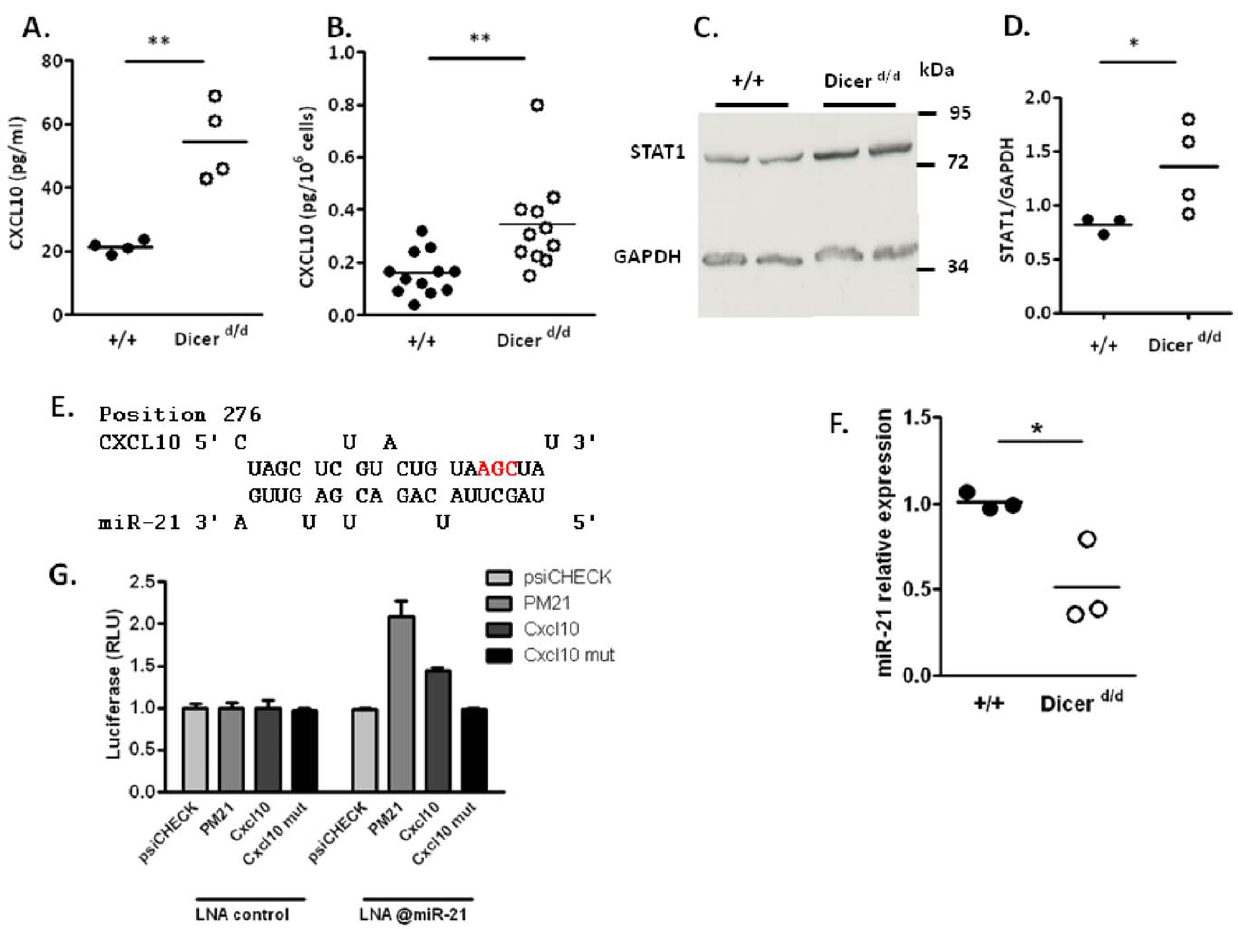
Figure 3. Increased protein expression of putative miRNA-targeted genes in Dicer d/d mutants. A. CXCL10 was quantified in the serum of naı¨ve controls (black dots) and Dicer mutant mice (white dots). B. CXCL10 (expressed in picograms for 1 6 10 6 cells) quantification in the supernatant of macrophages harvested from wild-type ( + / + ) and Dicer d/d mutants. C. STAT1 expression visualized by Western blot performed on spleen extracts from two control animals and two Dicer d/d mutant mice. GAPDH serves as loading control. D. Quantification of STAT1 signals in spleen protein extracts normalized to GADPH was done for 3 controls and 4 mutants. E. Sequence alignment of murine miR-21 and its target sequence in the Cxcl10 3’UTR. The mutated nucleotides disrupting miR-21 binding in the mutated Cxcl10 3’UTR are shown in red. F. miR-21 expression is reduced in Dicer d/ d splenocytes compared to wild-types. qRT-PCR was used to quantify miR-21 expression in wild-type and Dicer d/d splenocytes. G. Normalized Luciferase expression (RLU) in HeLa cells. Control or anti-miR-21 (@miR-21) tiny LNAs were incubated with HeLa cells for 24 h. Afterward, cells were transfected with empty vector (psiCHECK-2), or vectors containing a perfect match for miR-21 (PM21), the wild-type Cxcl10 3’UTR, or a mutated Cxcl10 3’UTR downstream of the f-luc gene.